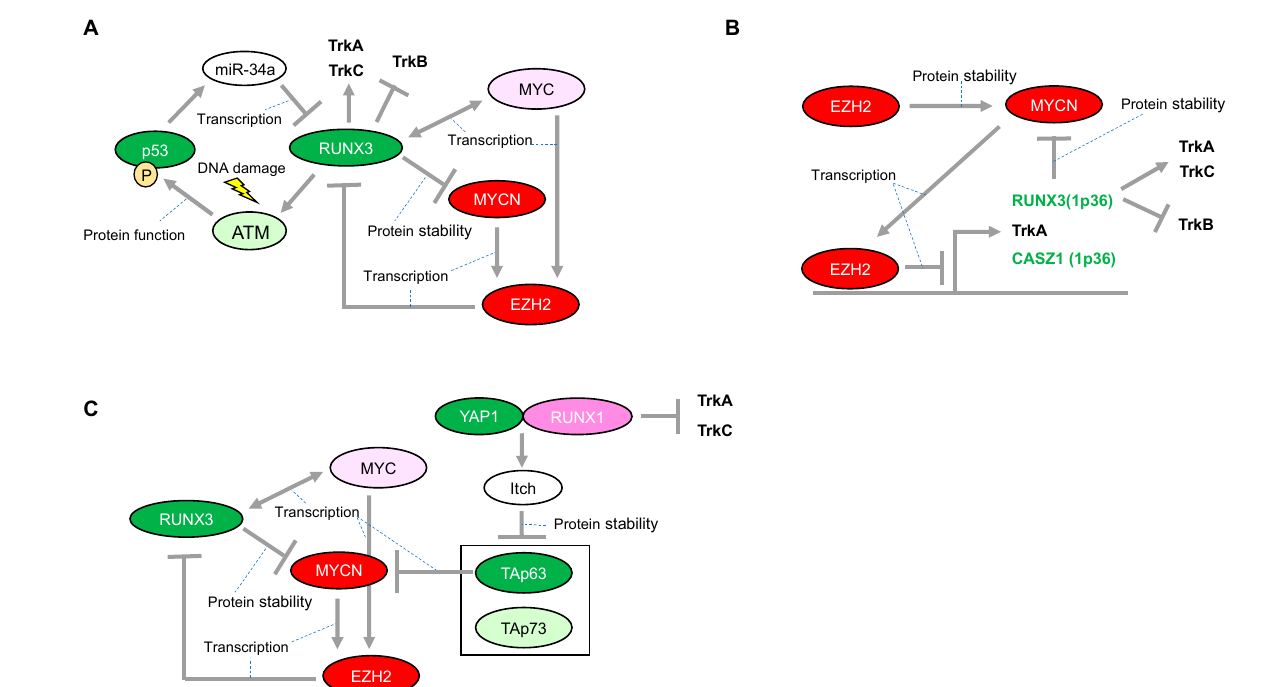
Figure 4. Proposed network between RUNX3 and MYCN in neuroblastomas with presence or absence of functional p53. ( A ) Expressional and/or functional regulation between the RUNX3 and p53 families. ( B ) Enhancer of zeste 2 (EZH2)-mediated epigenetic regulation is associated with neuroblastoma aggressiveness through transcriptional repression of RUNX3. ( C ) RUNX1-dependency in p53 non-functional neuroblastomas. The red-colored or green-colored molecules indicate oncogenes or tumor-suppressors in neuroblastomas, respectively. The pink-colored RUNX1 could positively affect neuroblastoma proliferation. The light-pink-colored or light-green-colored molecules could positively or negatively affect neuroblastoma proliferation, respectively, and the non-colored molecules are undetermined.